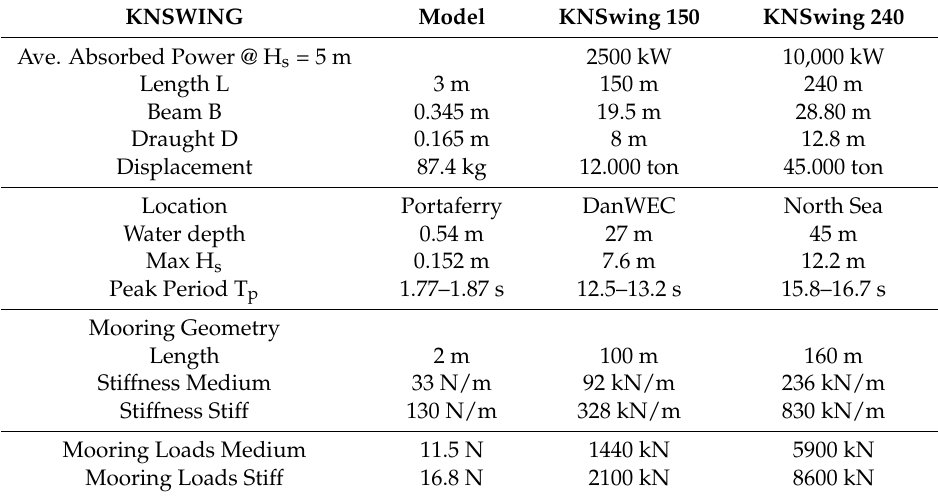
Table 7. Dimensions of the scaled-up version of